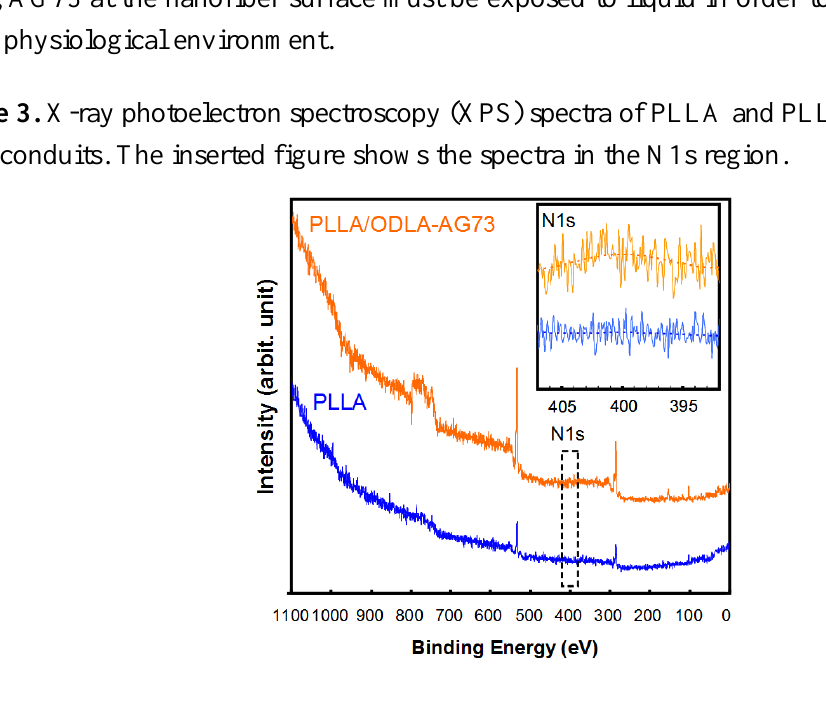
Table 1. Elemental ratios of nitrogen to carbon (N1s/C1s) and oxygen to carbon (O1s/C1s) at the surface of PLLA and PLLA/ODLA-AG73 nerve conduits, measured by XPS ( n =